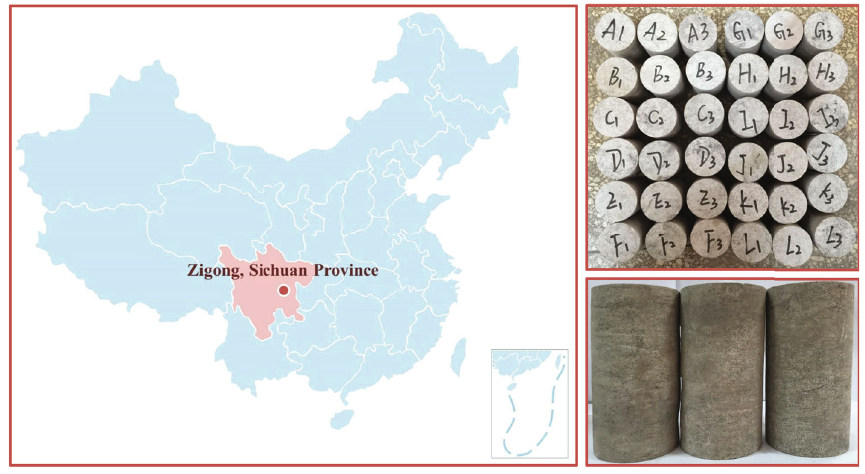
Figure 1: Sandstone